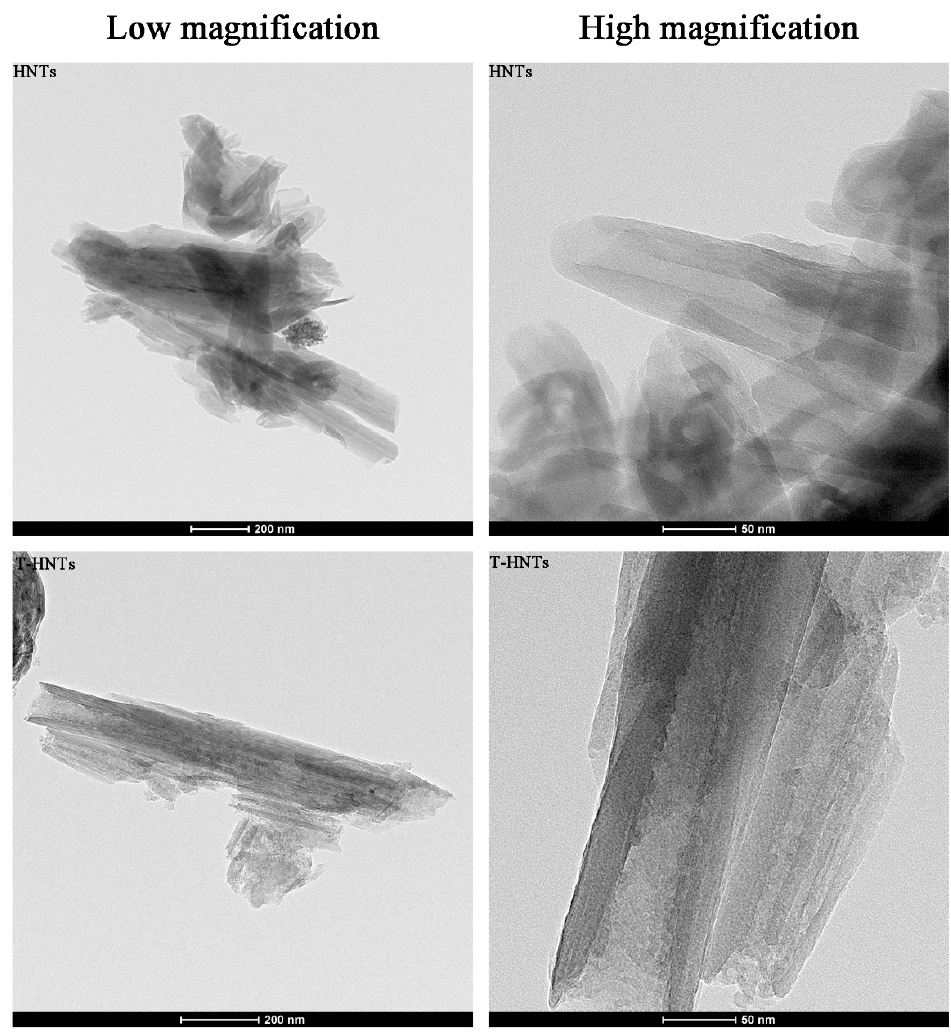
Figure 1. TEM images of HNTs and T-HNTs. The porous structure parameters of HNTs, T-HNTs, and T-HNTs-CIN are shown in Table 1. After HNT was etched by sulfuric acid, its specific surface area increased from 25.50 to 76.61 m 2 /g, and its pore volume increased from 0.30 to 0.39 m 3 /g, which